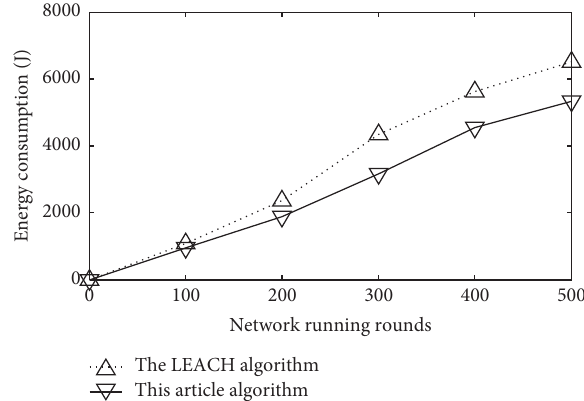
Figure 12: Energy consumption comparison in this article’s al- gorithm and the LEACH algorithm under different network running